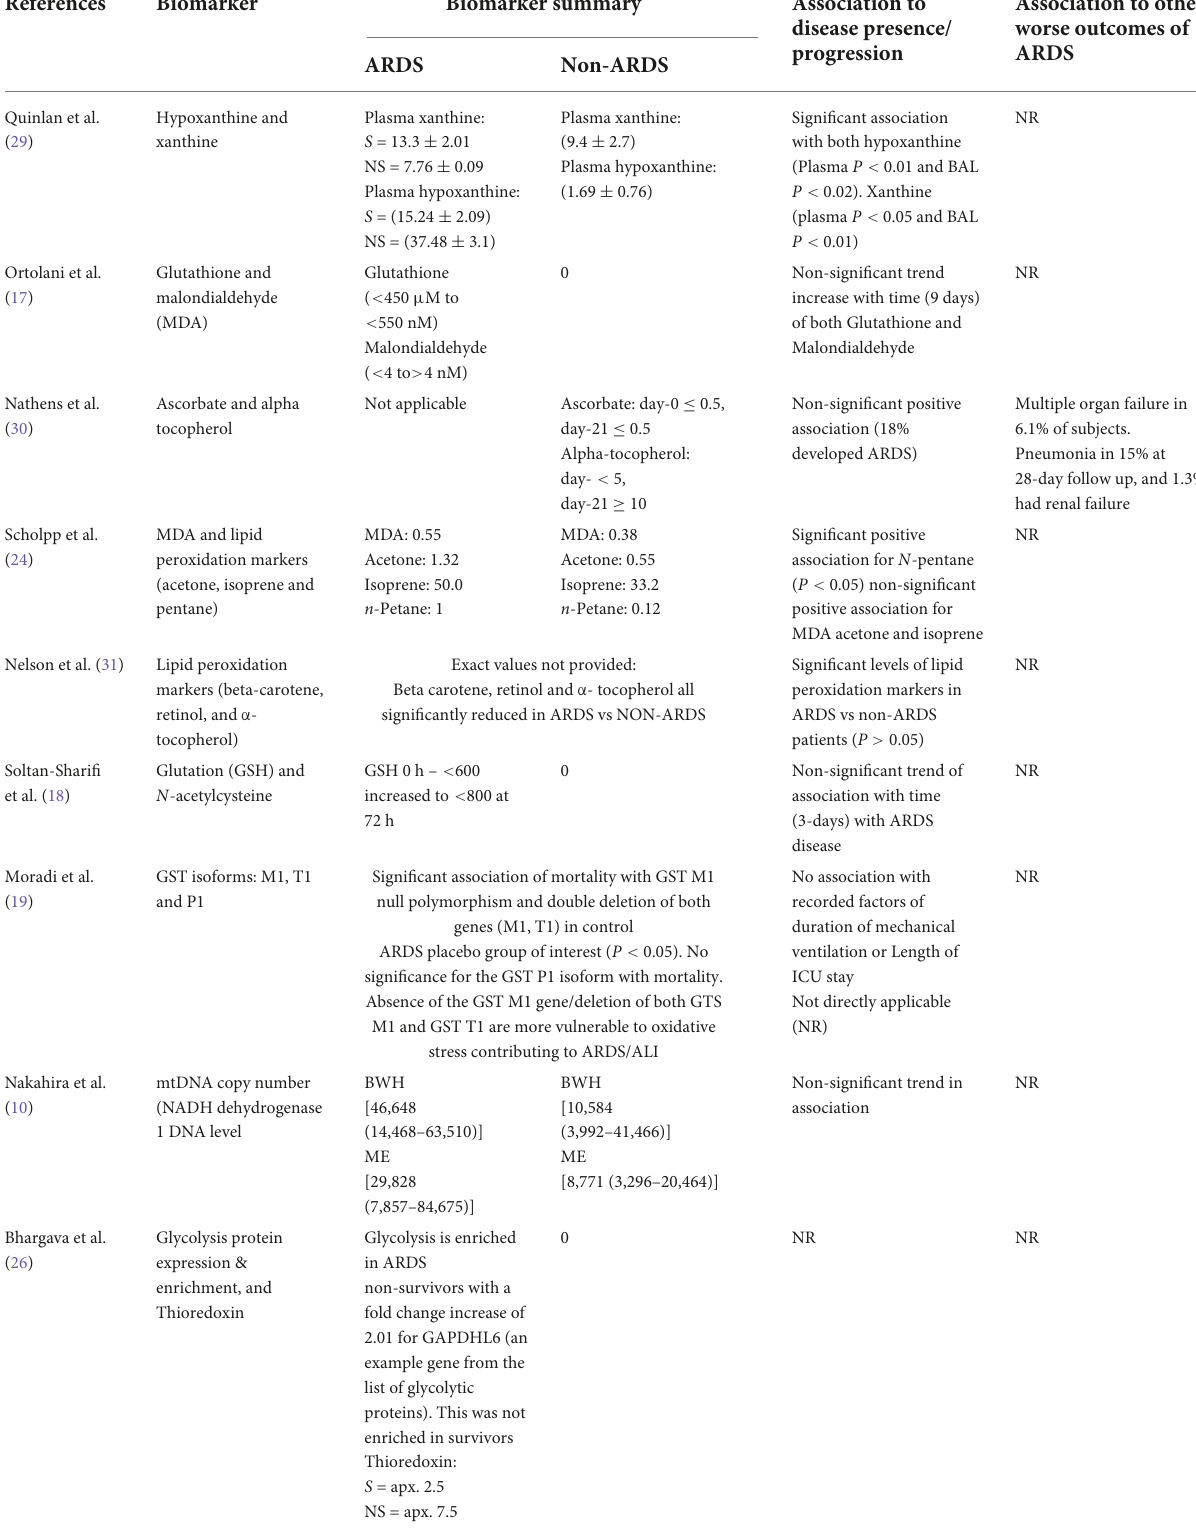
TABLE 5 Secondary outcome: Association between levels of mitochondrial biomarkers and risks of development of new complications of ARDS or worsening of severity or development of